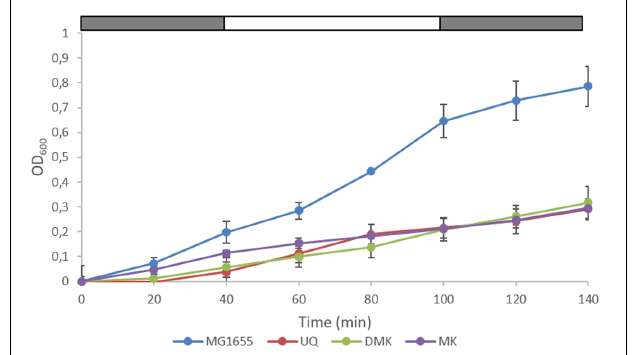
FIGURE 3 | Growth of wild type E. coli and the three single quinone strains in (an)aerobic transition experiments. The last three data points correspond to anaerobic growth, except the MK-only strain for which the last two points are anaerobic. The bar above each panel indicates sparging with N 2 (gray) or air (white). Data represent the average of three biologically independent replicates, error bars indicate the standard